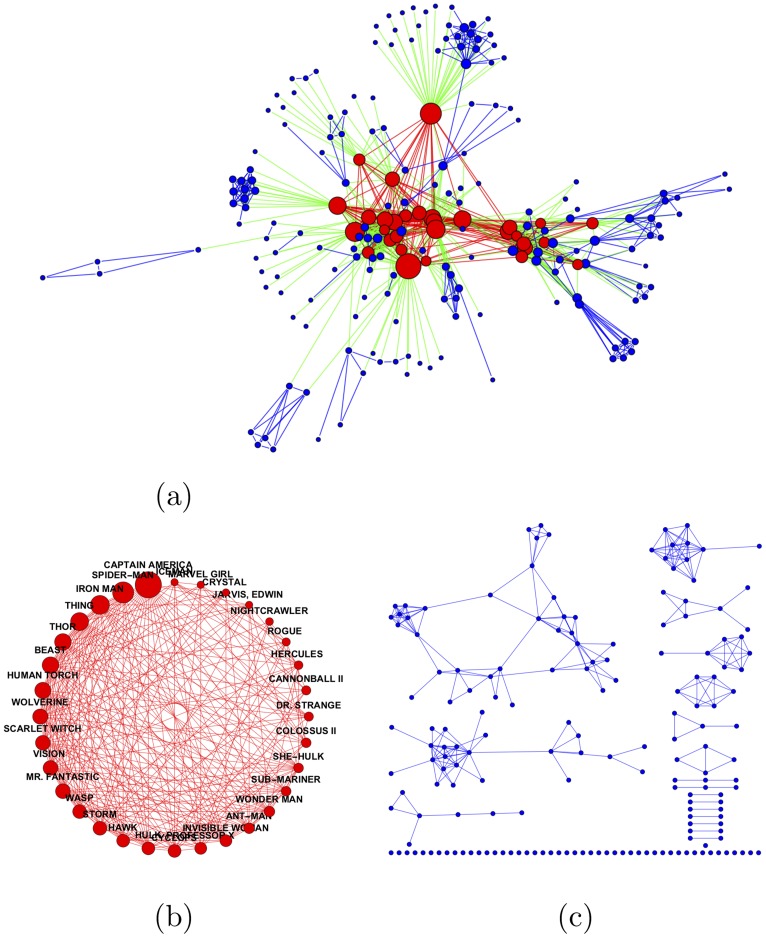
Fictional illustrative example: The social network of the Marvel’s superheroes.Two heroes are linked if they appeared together in at least 50 comic book titles [18]. (a) The network (208 superheroes, 912 edges), partitioned into an elite (red nodes and internal edges) and a periphery (green nodes and internal edges). Blue “crossing” edges connect elite and periphery nodes. (b) The (dense) elite subgraph (32 nodes, 259 edges). (c) The (sparser) periphery subgraph (176 nodes, 257 edges).